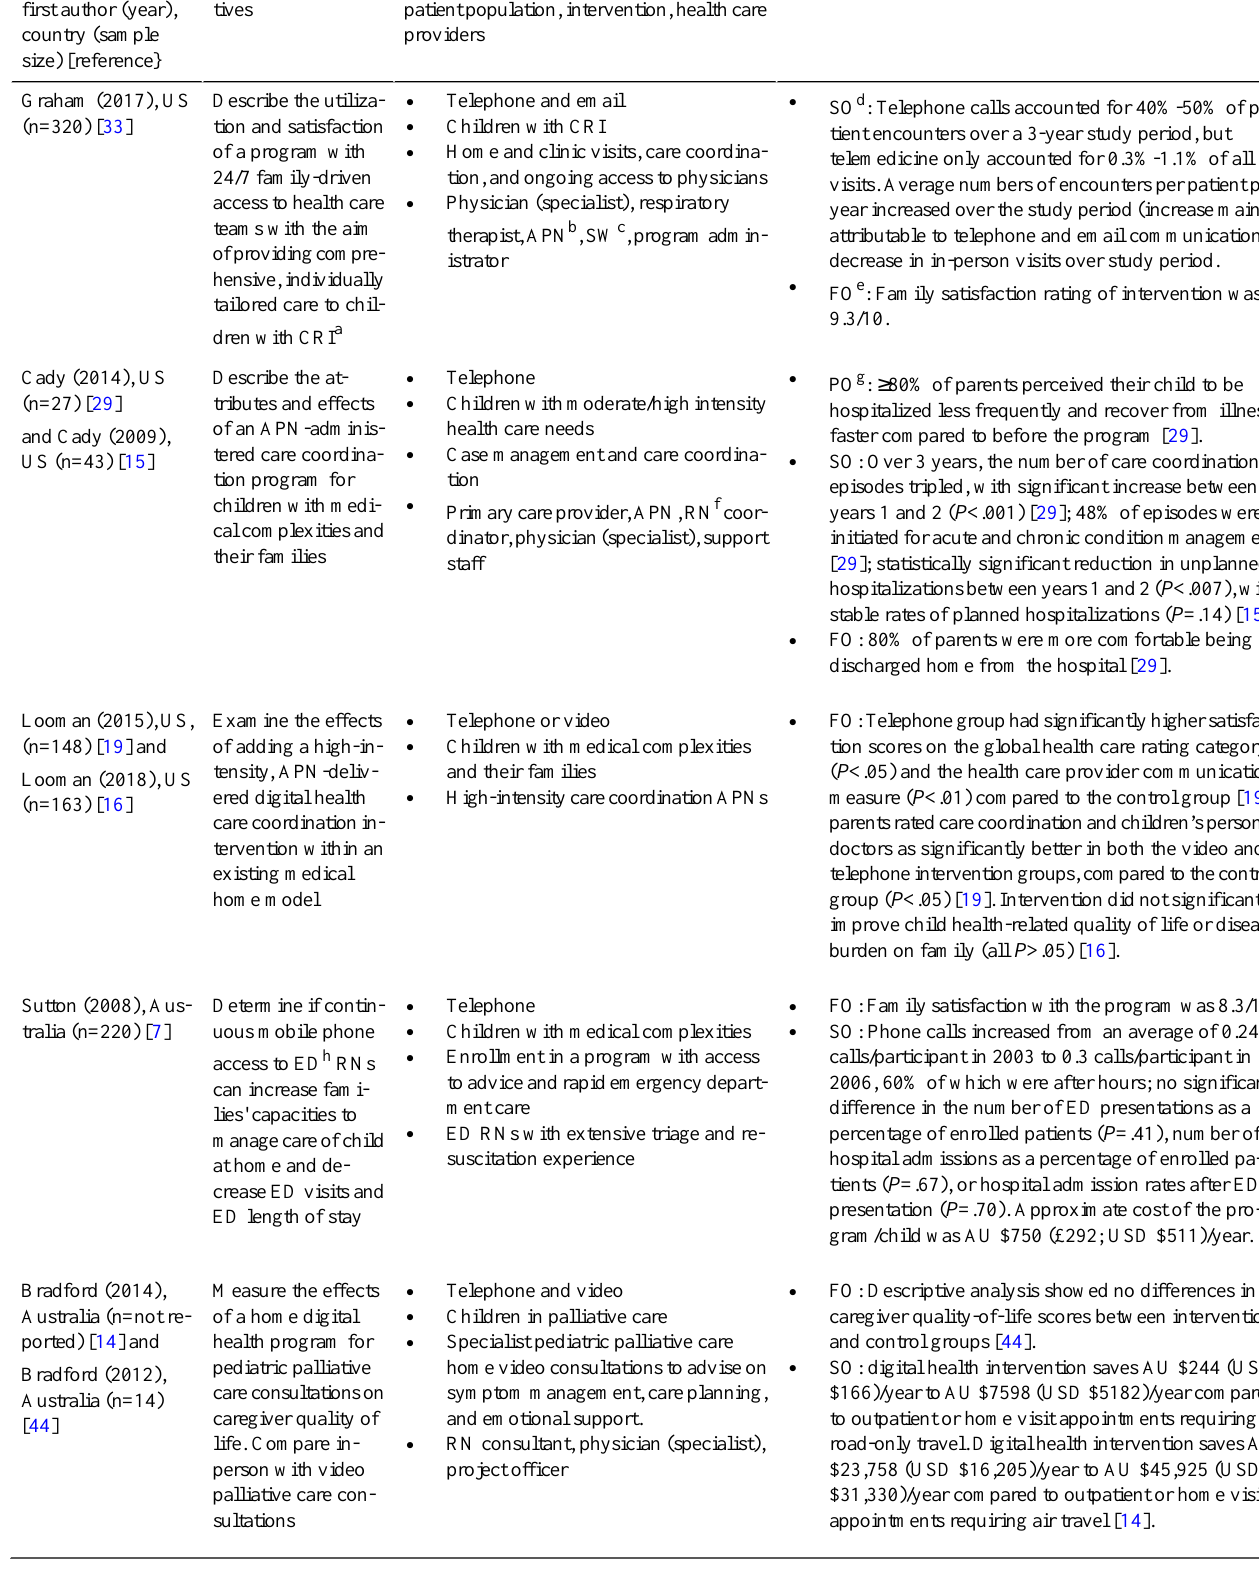
Table 4. Interventions to provide direct patient care via digital health. providersStudy purpose: objec- tivesStudy identifiers: patient population, intervention, health care first author